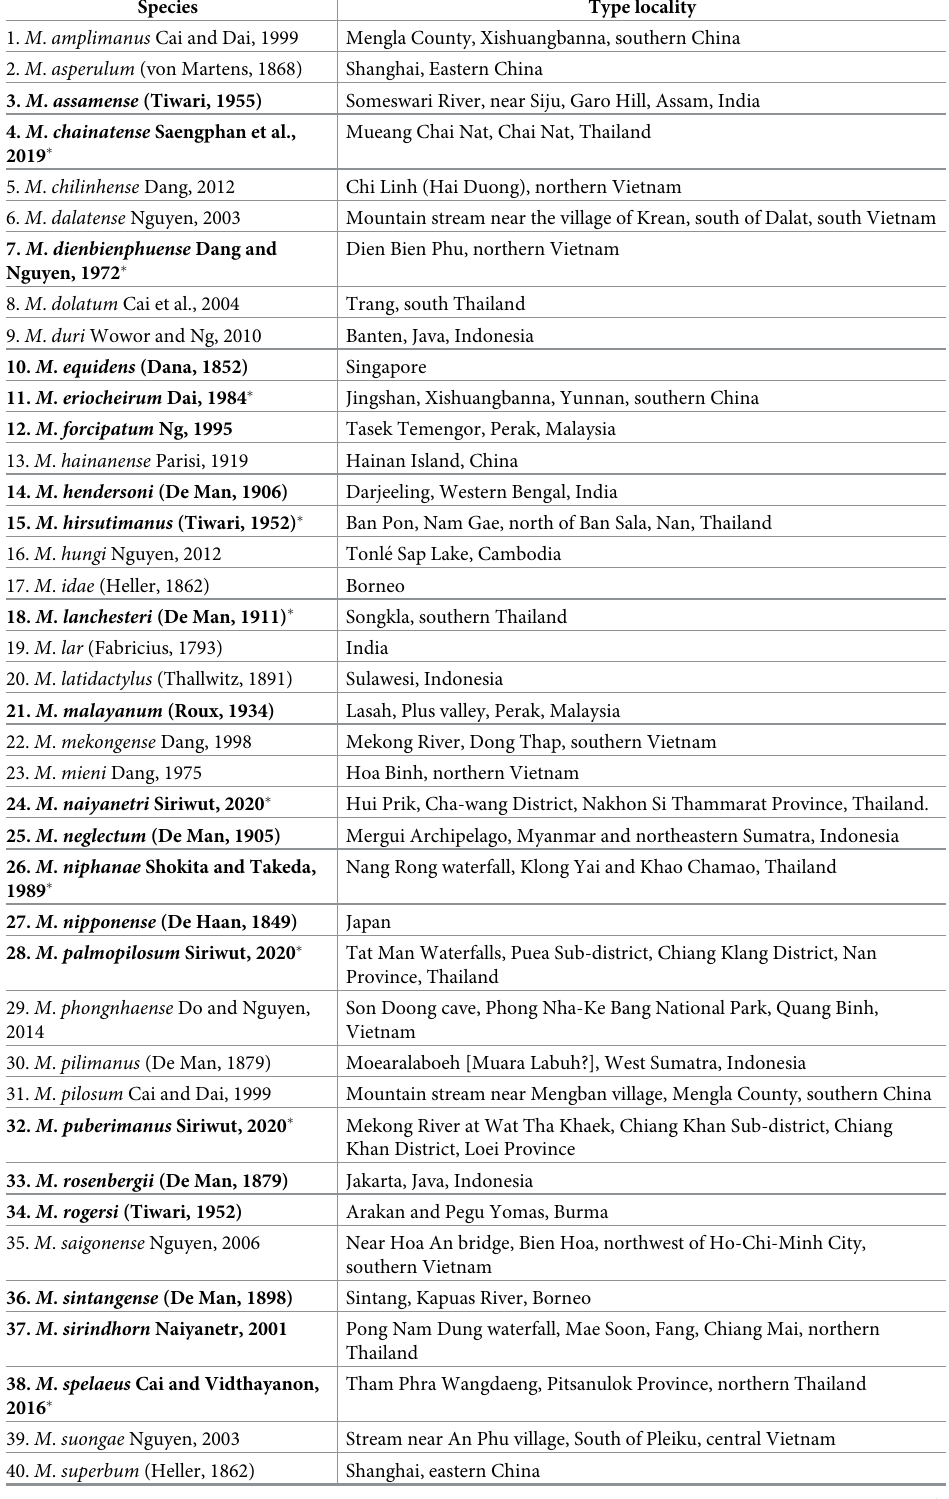
Table 1. Species records of Indochinese Macrobrachium prawns.